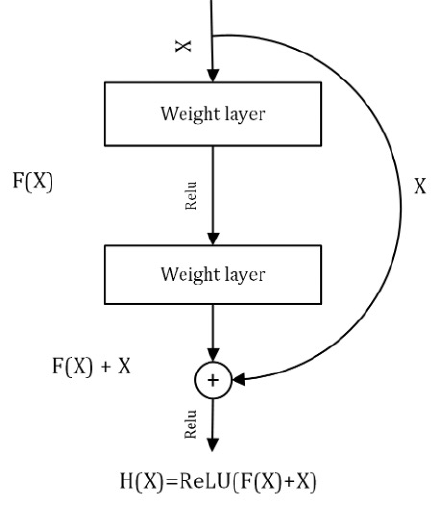
Figure 4. Residual block of deep Residual